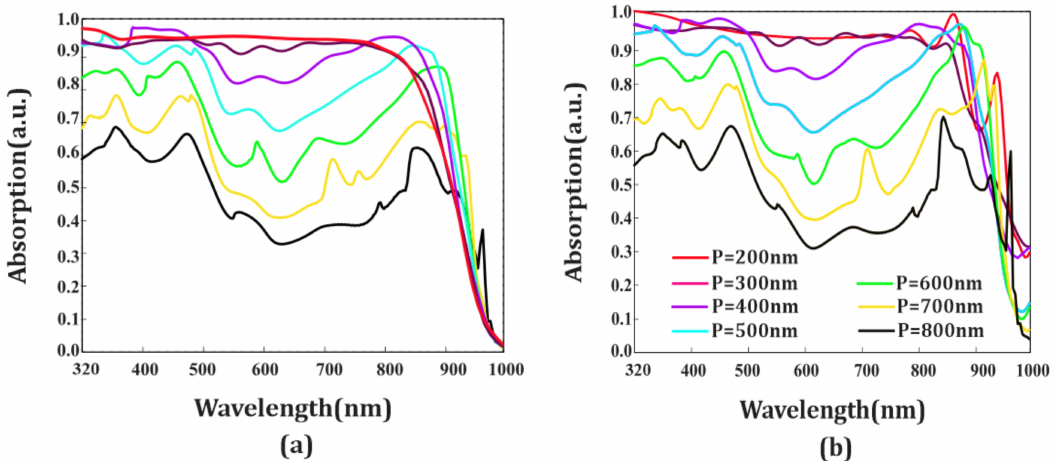
Figure 9. Absorption spectra for varying pitch for ( a ) bare cell and ( b ) proposed cell.